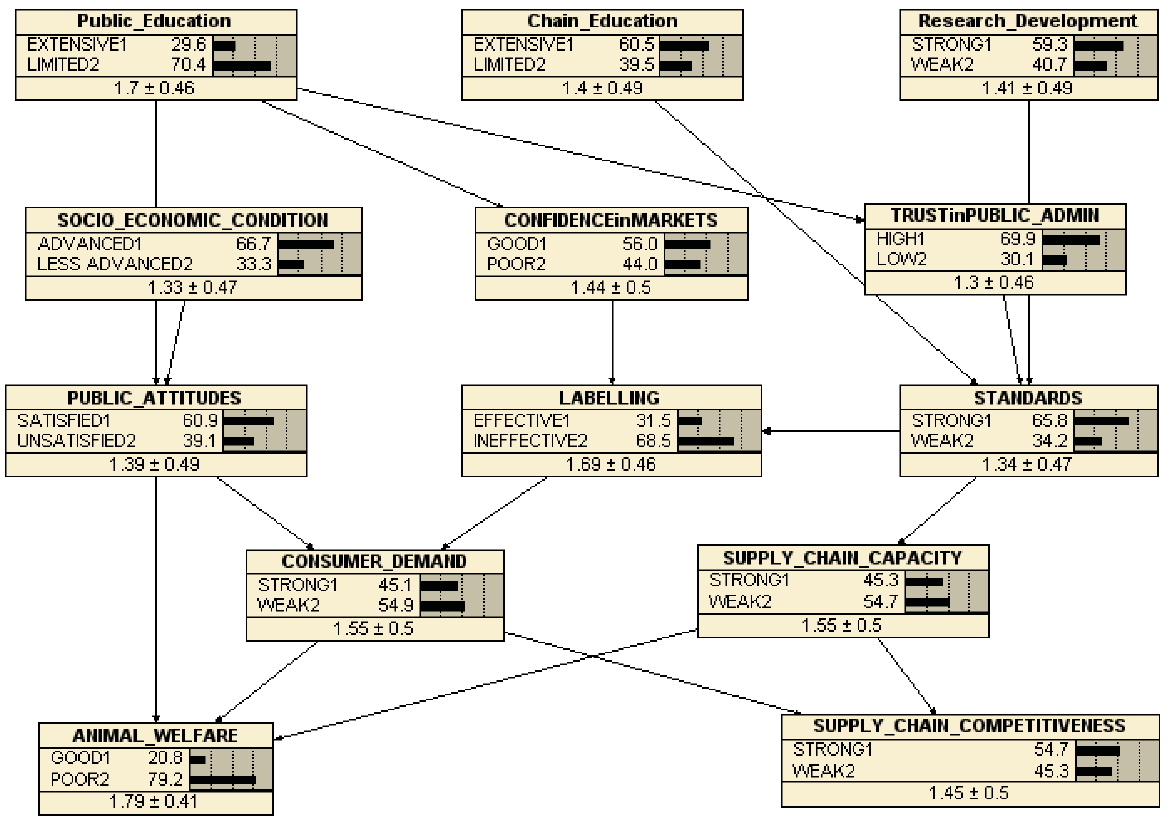
Figure 4. Calibrated EconWelfare Belief